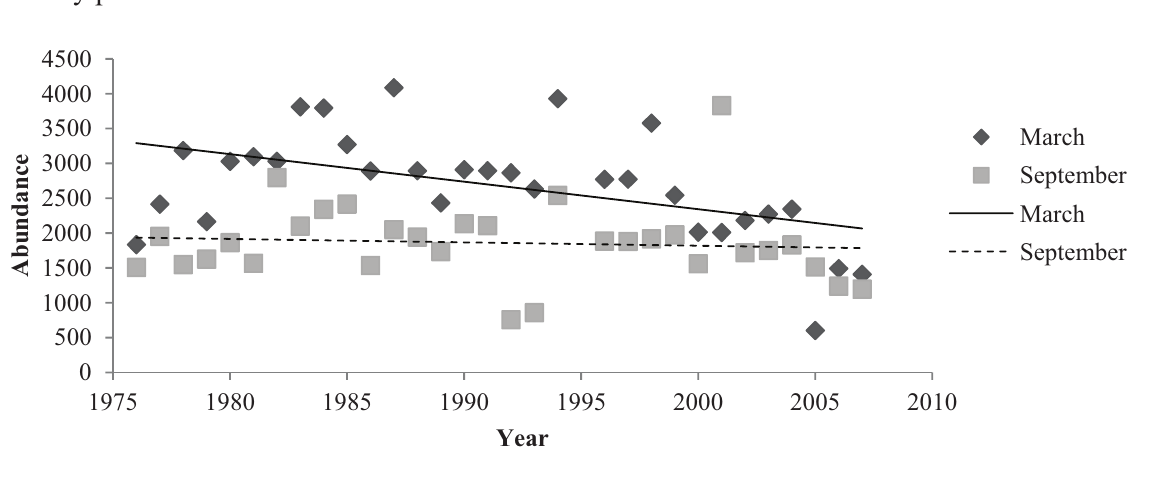
Figure 5. The abundance of native birds in March and September months in the Adelaide City parklands from 1976 to 2007.